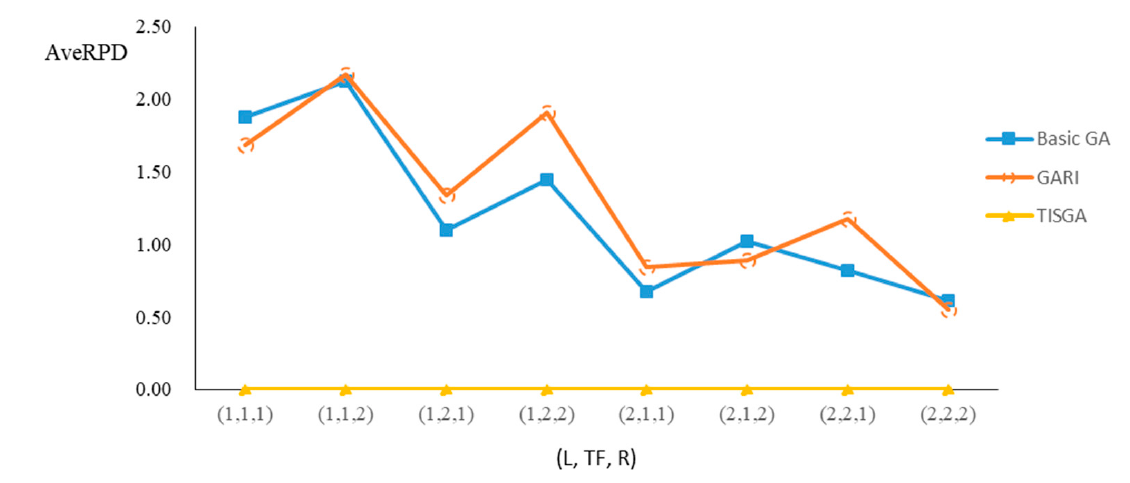
Figure 14. Comparison results for n = 50 with eight combinations of (L, TF, R).